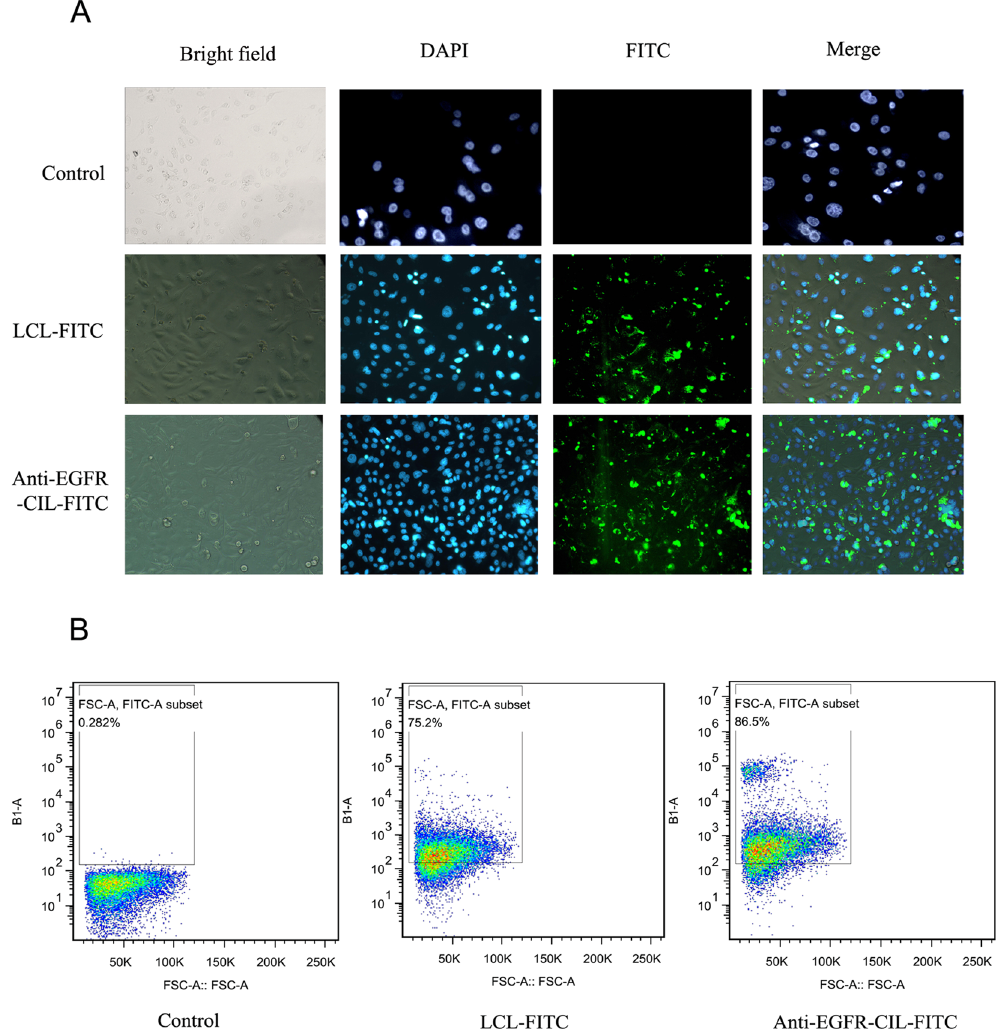
Figure 3. Fluorescence microscopy ( A ) and flow cytometry ( B ) images of GBC-SD cells incubated with various liposomes containing FITC at concentrations of 100 nmol/l for 24